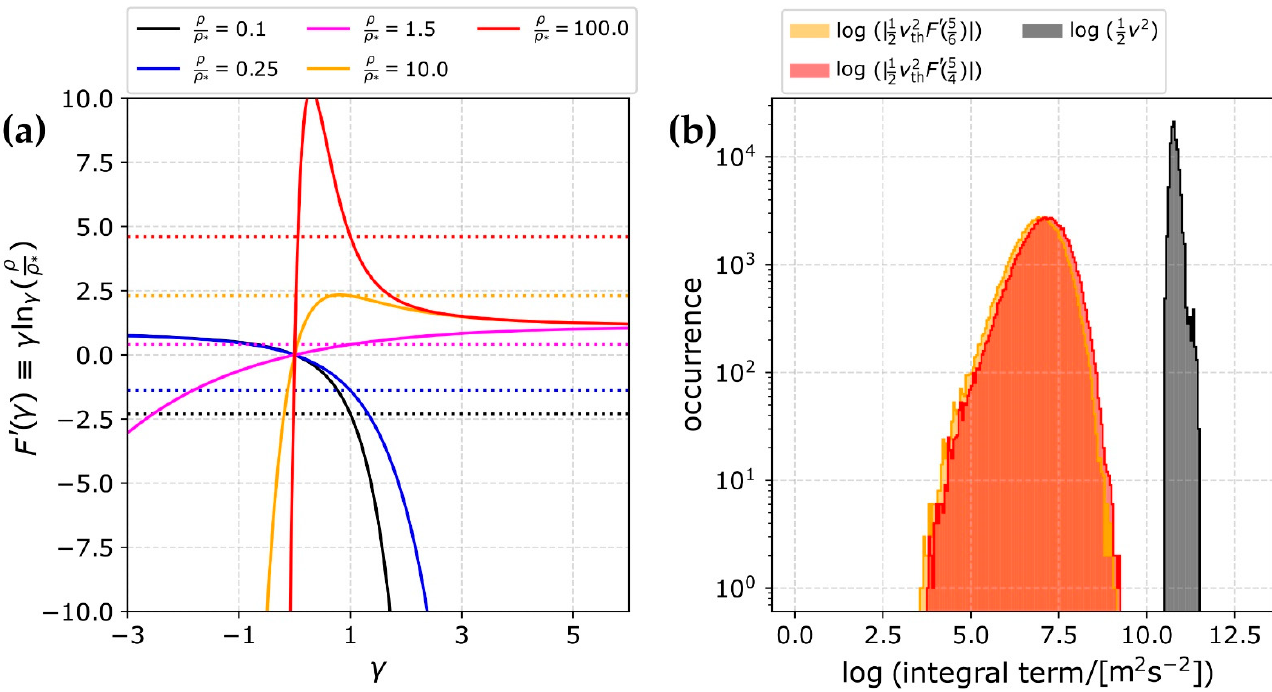
Figure 6. ( a ) The function F (cid:48) ( γ ) ≡ γ · ln γ , which multiplies the thermal term in the complete Bernoulli integral as a function of γ and for several ρ ratios. ( b ) Histograms of the (grey) dynamic term and the absolute value of the second term of Equation (7) as calculated from Wind observations, assuming (orange) γ = 5/6, and (red) γ = 5/4.